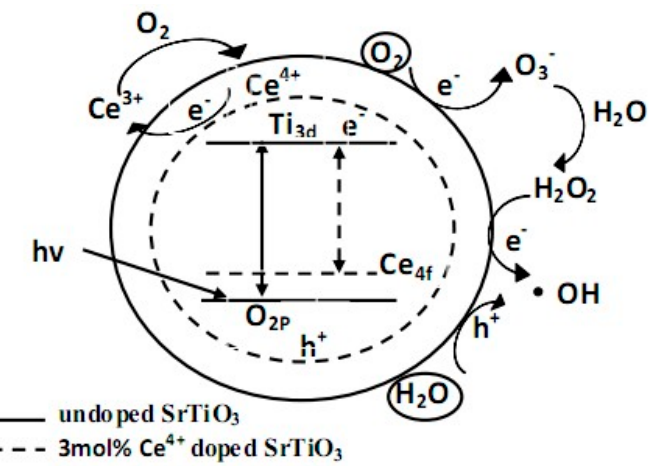
Figure 13. Schematic diagram of photocatalytic mechanism.